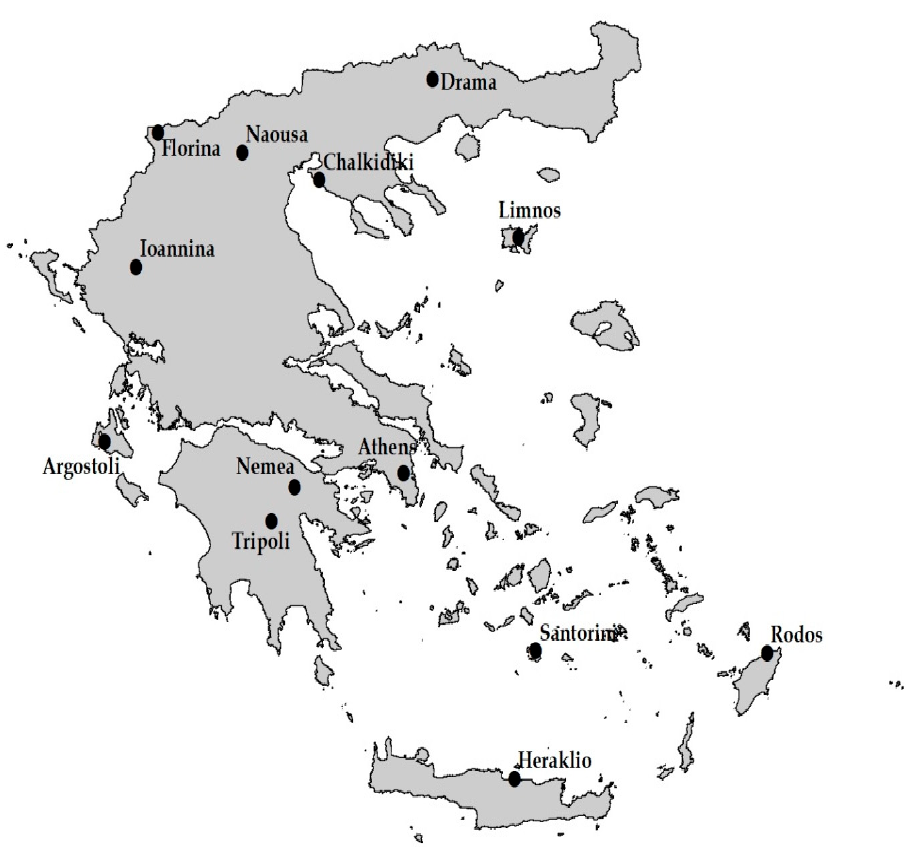
Figure 1. Map of Greece showing the locations of the wine-producing locations used in this study. Table 1. Details for the 11 principal winegrape varieties (10 indigenous and 1 international) culti- vated in 13 principal winegrape areas in Greece. Varieties and regions are presented in the first two columns. The predominant type of wine produced per region , the period of records and the respec- tive total number of wines used per variety, are given in the last two columns. Each variety has superscript letters indicating indigenous (a) and international varieties (b); early (E), mid (M), and late (L) season varieties [24]; and red (R) and white (W) varieties. ** correspond to two missing wine quality scores on each case.